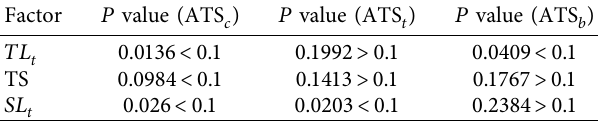
Table 4: Experiment 3 simulations.